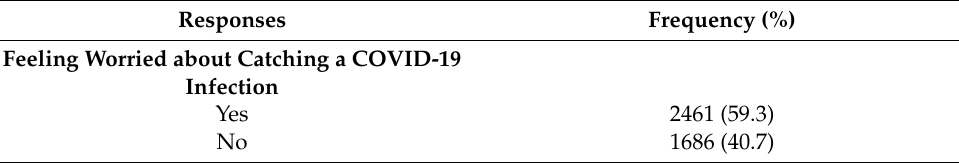
Table 2. Information related to the COVID-19 infection ( n =